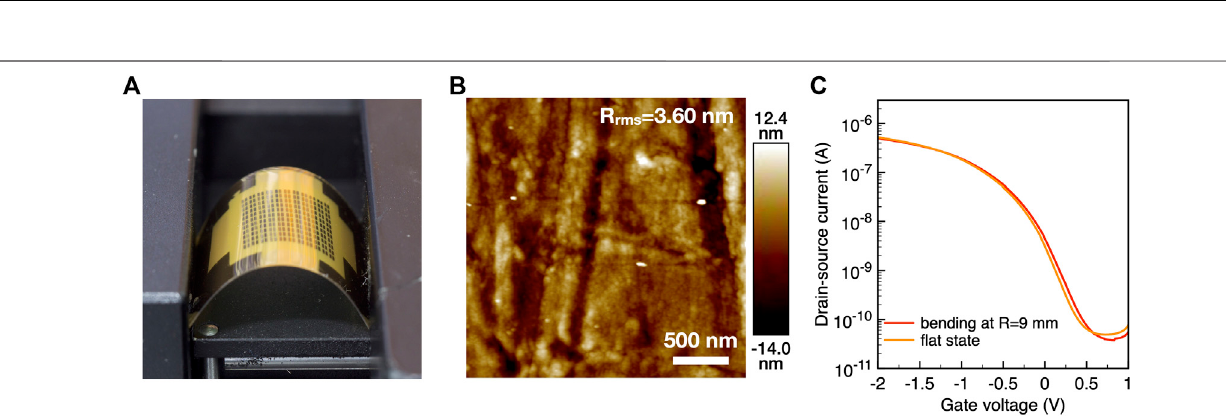
Frontiers in Materials |